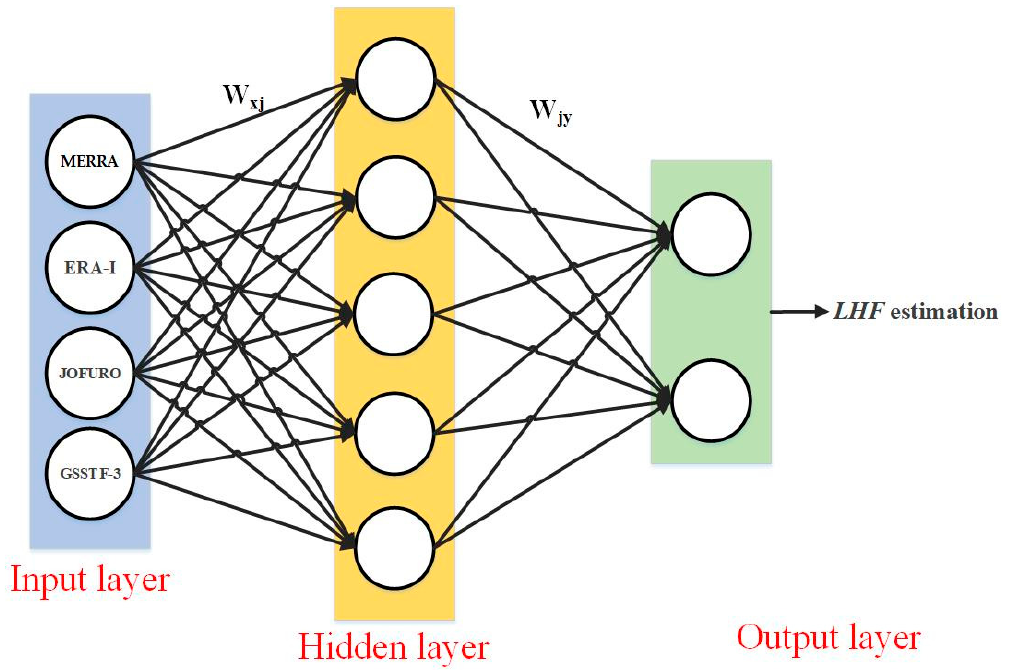
Figure 2. The structure of Artificial neural network ( ANN ) algorithm.